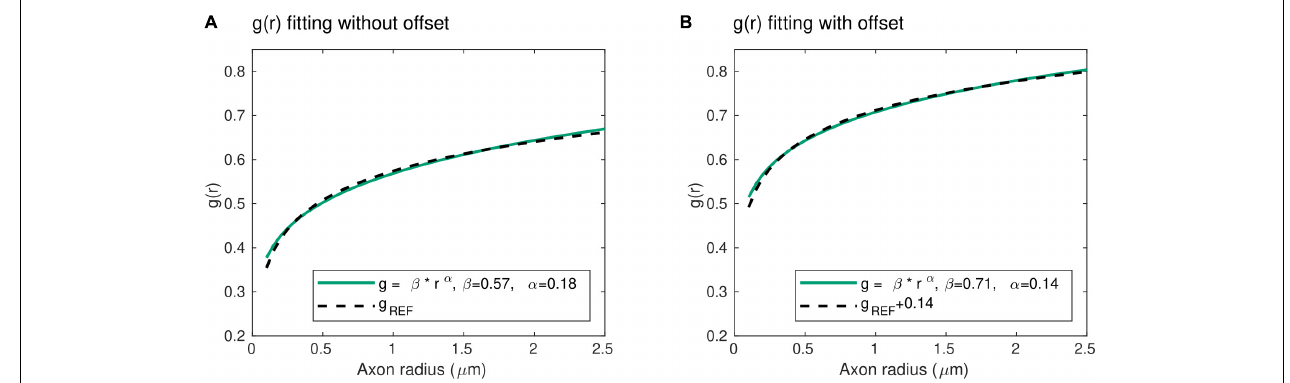
FIGURE 2 | Radius dependence of the g-ratio. (A) An excellent agreement ( R 2 = 0.99) is found between the proposed power law (green line) and reference histological measures of the g-ratio [ g REF (Ikeda and Oka, 2012), dashed line], with α = 0.18 and β = 0.57 µ m − α . (B) The higher axonal g-ratios in the human central nervous system were accounted for by adding an offset of 0.14 to the reference peripherical nervous system data. The agreement between the proposed power law and the reference g REF remains very high ( R 2 = 0.99), with α = 0.14 and β = 0.71 µ m − α .